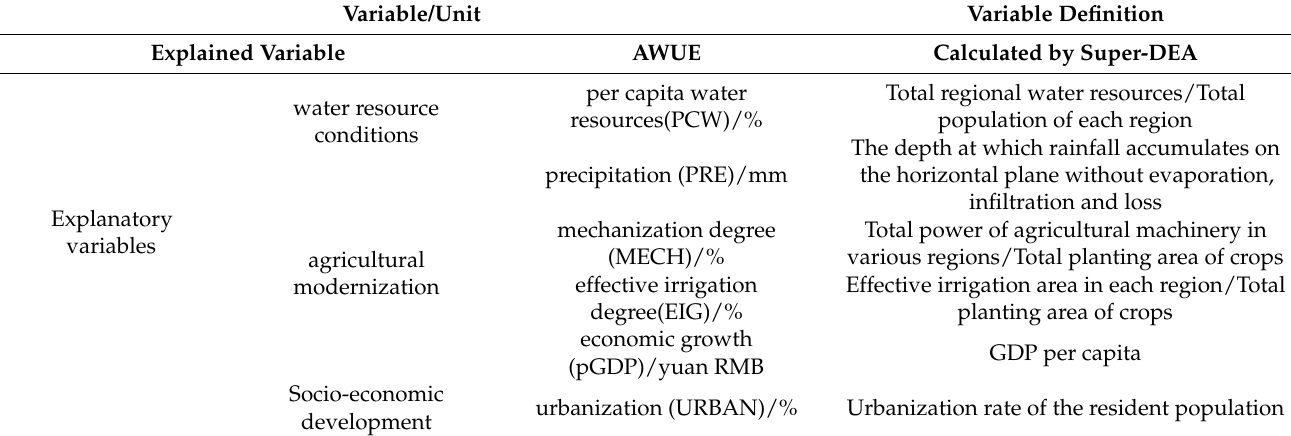
Table 2. Variable selections and definitions. DEA: data envelopment analysis.